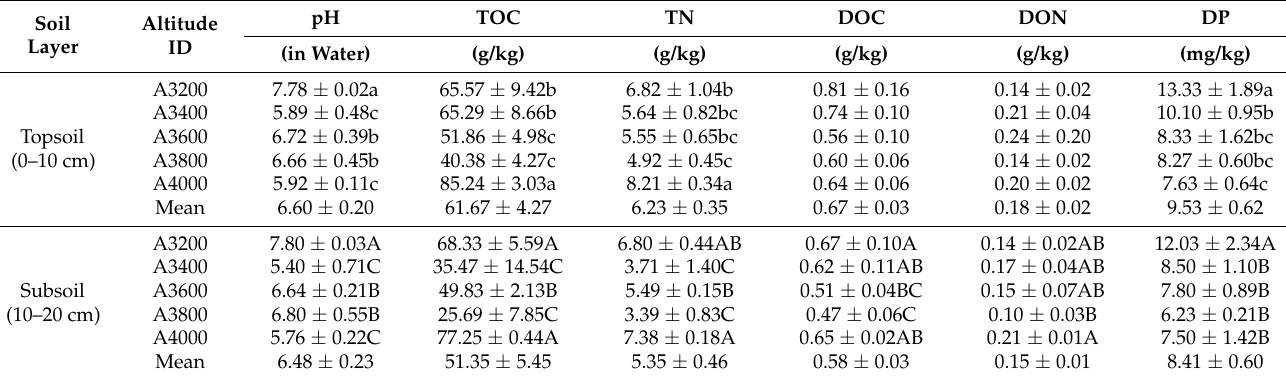
Table 2. Soil chemical properties of the sampling